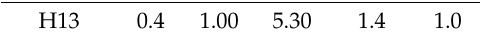
Table 6. Control process parameters and their levels.